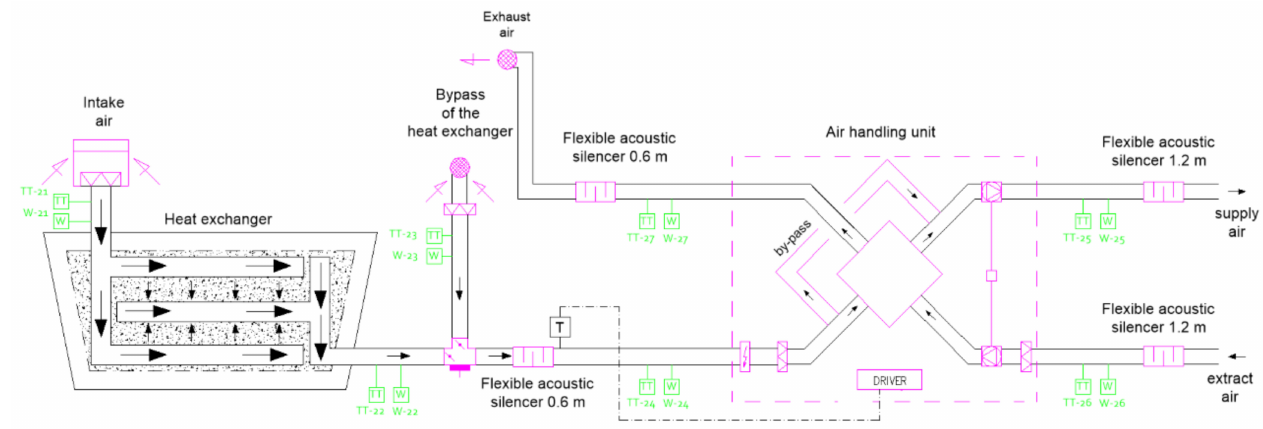
Figure 19. Diagram of integration of gravel-type EAHE into the mechanical ventilation system of a single-family building [81].